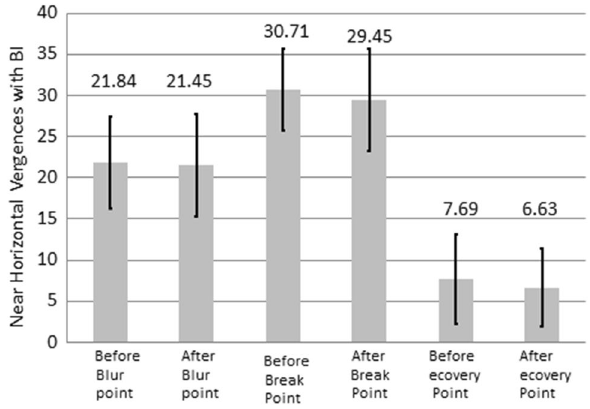
Figure 5. NHV with BI changes before and after using VR for watching 3D film.